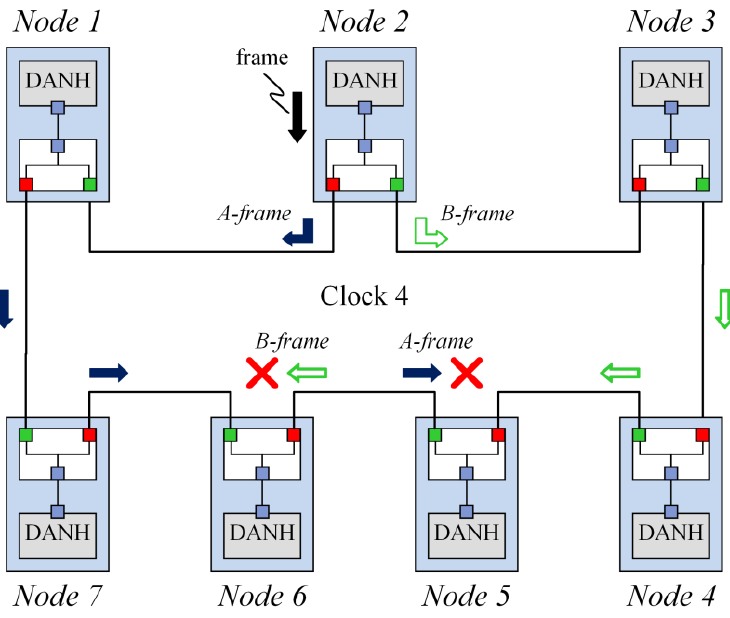
Figure 3. Removing duplicates in a single ring under the QR